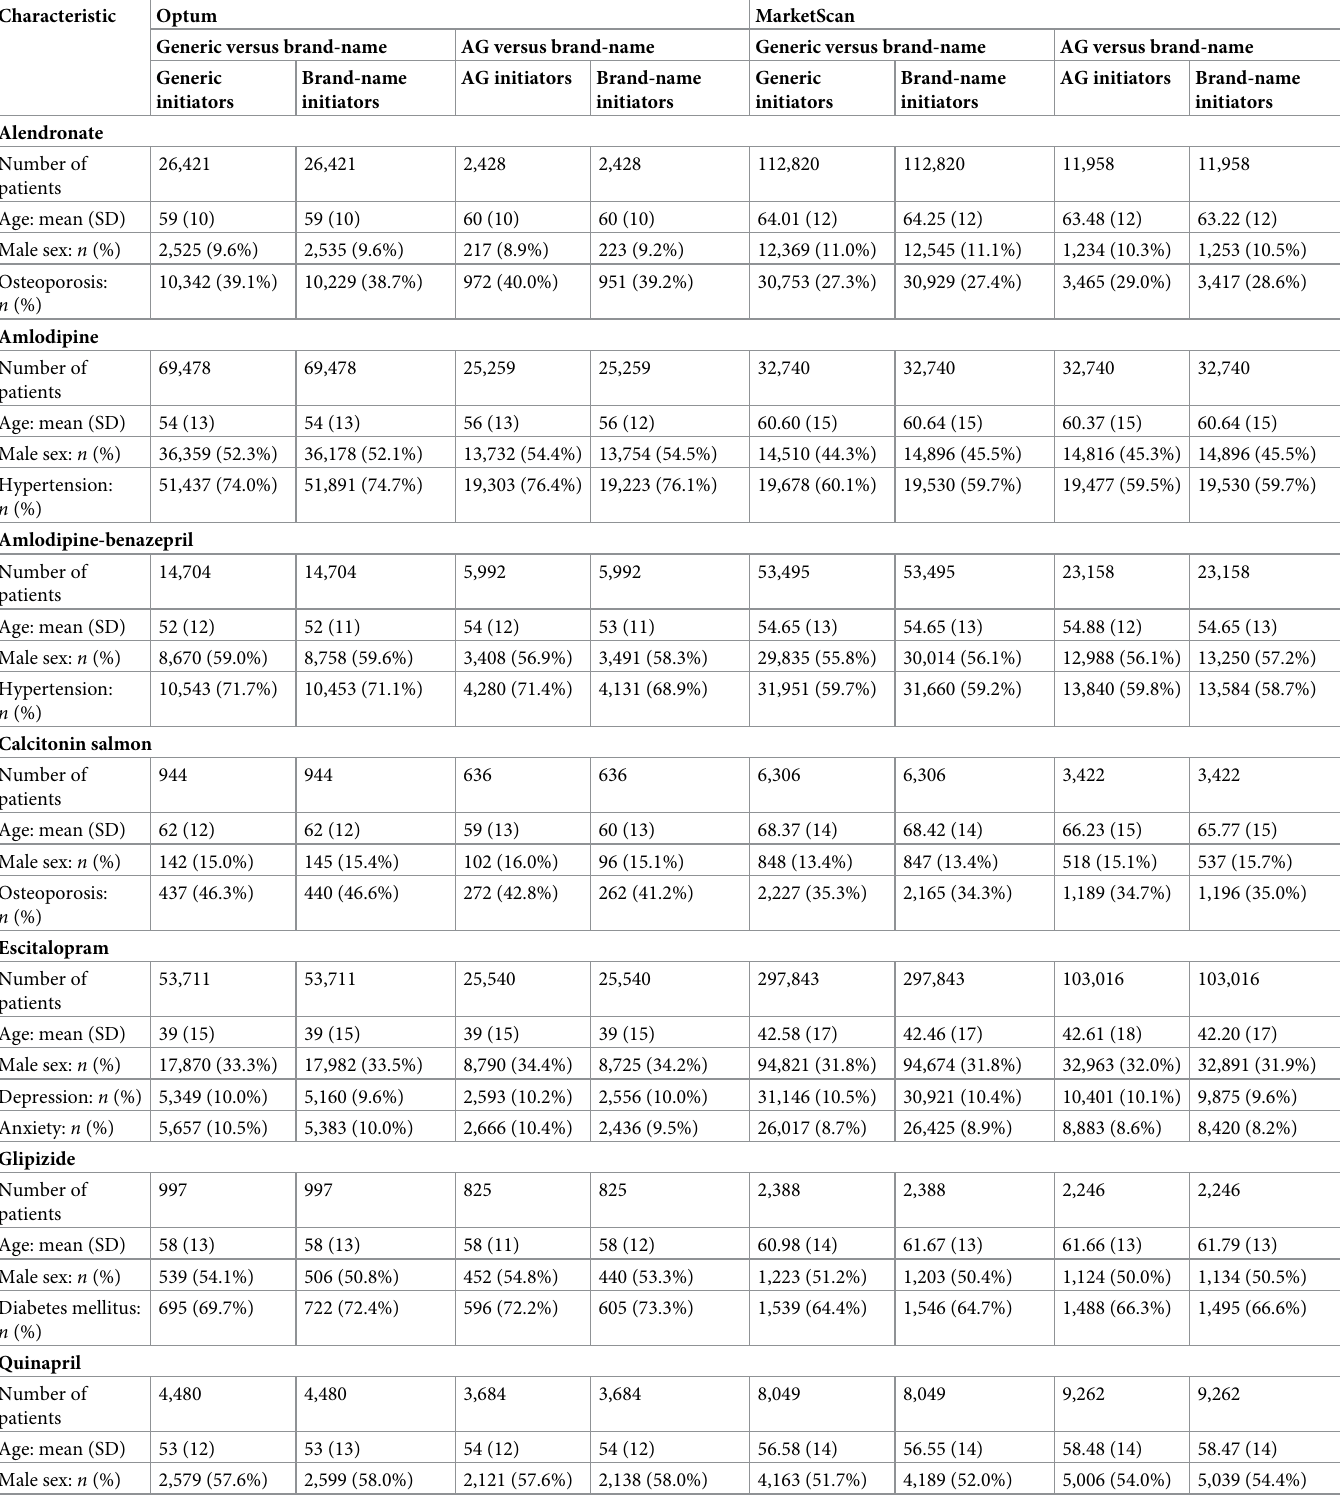
Table 3. Characteristics of patients included in the evaluation of comparative outcomes for generic or authorized generic (AG) versus brand initiators after 1:1 pro- pensity score matching in each database.